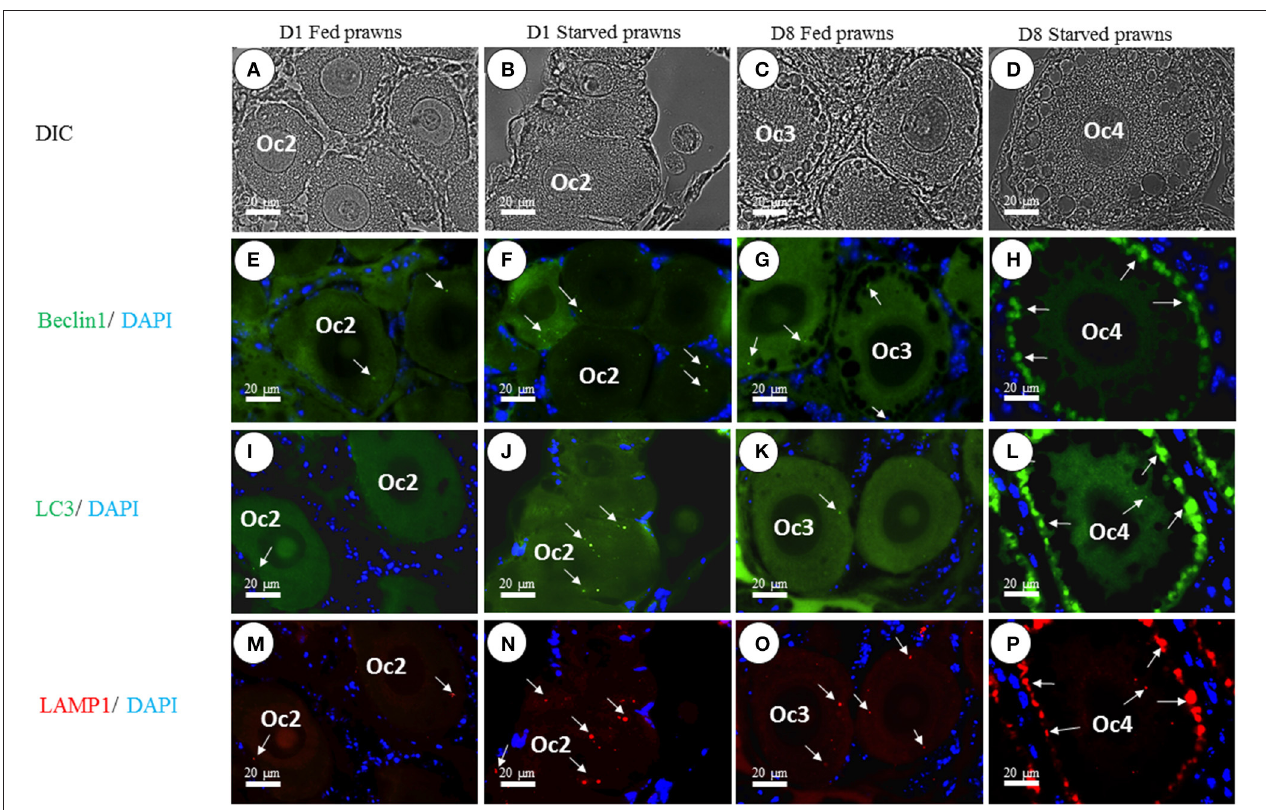
FIGURE 5 | Effect of starvation on autophagy in the oocytes. The immunoreactivity of autophagic-related proteins (ARP) in various stages of oocytes from Oc1 to Oc4 at days 1 and 8 was shown in DIC (A–D) . Lower panels showed immunofluorescence detection of Beclin1 (arrows in E–H ), LC3 (arrows in I–L ), and LAMP1 (arrows in M–P ). It was evident that the immunoreactivities of ARP were more intense in the ovaries of starved prawns, especially in late stage oocytes. Bar 20 µ m ( n =